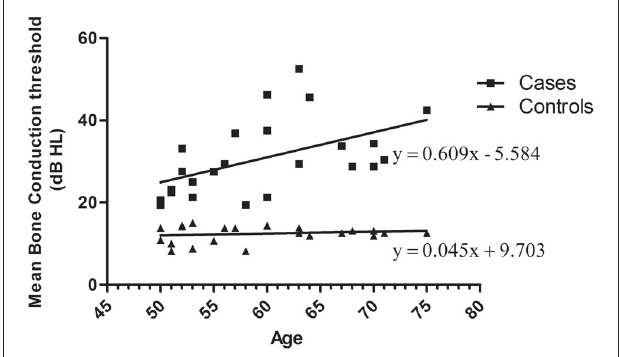
FIGURE 1 | Distribution of mean bone conduction threshold as a function of age in age-related hearing impairment (ARHI) cases and healthy controls, generated using GraphPad Prism 5.0. Means of the right and left ear hearing thresholds at 500, 1000, 2000 and 4000 Hz for bone conduction in patients were plotted as a function against subjects’ age ranging from 50 to 75 years. Hearing loss thresholds are expressed in decibels (dB). Linear regression equation and line were added for each data series of cases and controls.